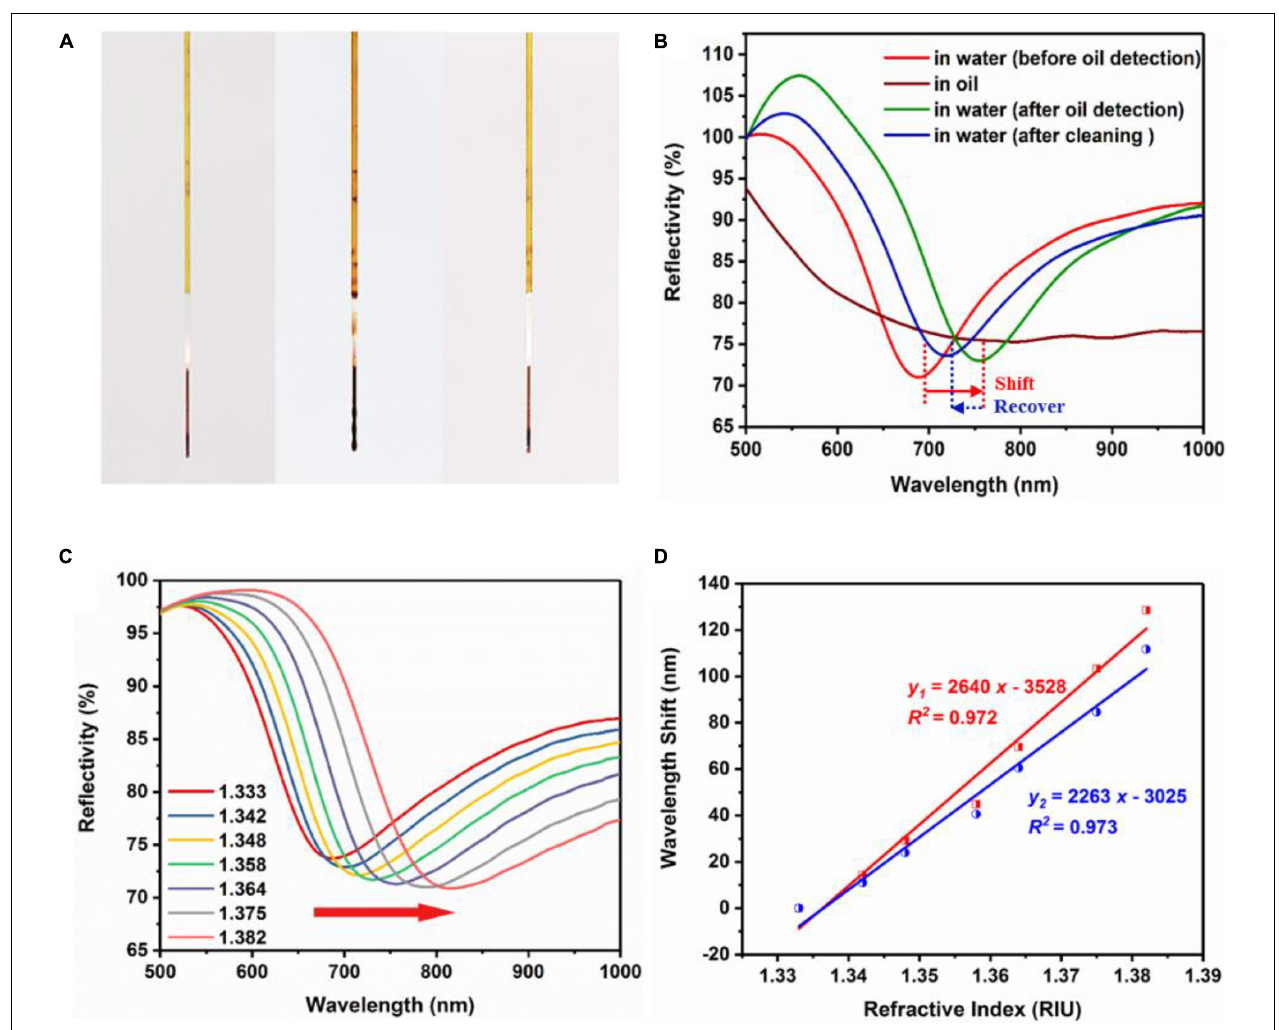
FIGURE 5 | Sensor repeatability experiment: (A) Photograph of optical SPR sensors (from left to right: initial, after oil detection, and after cleaning); (B) Optical SPR sensor spectrum under different processing; (C) Reflectivity spectra of the sensor in glucose solution with varying refractive indices; and (D) Linear curve of the wavelength shift and concentration of glucose solution ( y 1 : the sensitivity of optical SPR sensors before detecting oil, and y 2 : the sensitivity of optical SPR sensors after